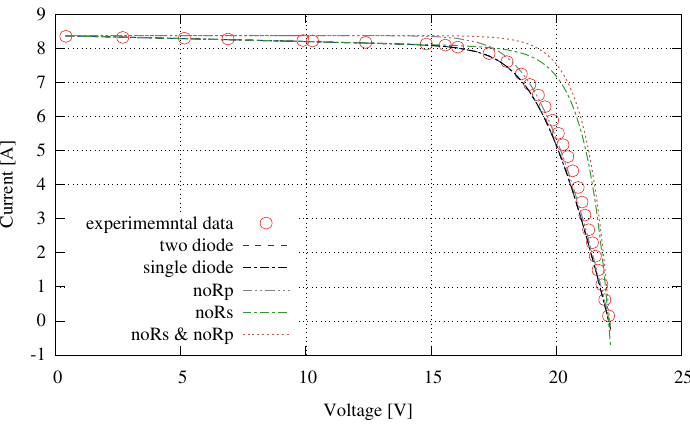
Figure 6. Results of model tuning for Kyocera KD135SX PV